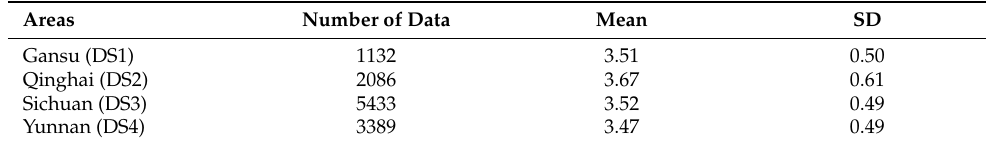
Table 3. Analyzed seismic areas of